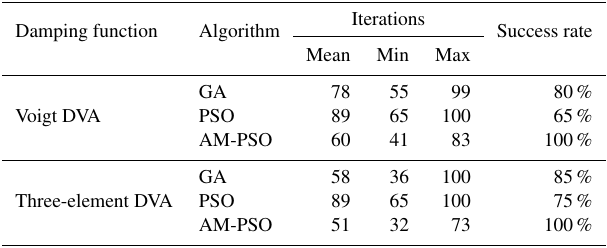
Table 1. Number of iterations for Voigt DVA and three-element DVA after 40 independent